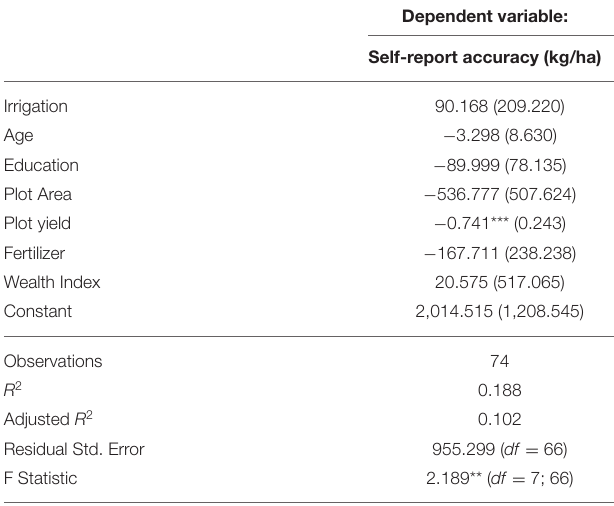
TABLE 1 | Multiple linear regression results for the socio-economic, management, and biophysical variables associated with self-report accuracy